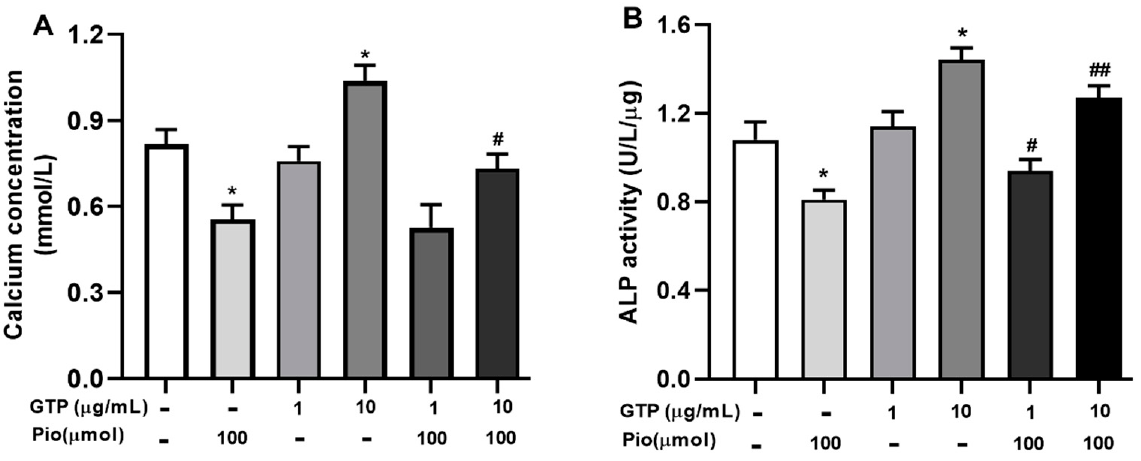
Figure 4. Green tea polyphenols (GTPs) increase calcium content and ALP activity in mature